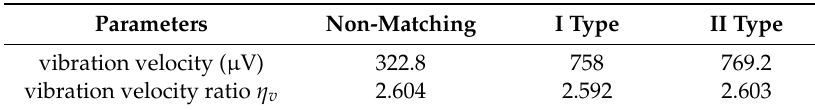
Figure 10. The vibration velocity of the single sandwiched piezoelectric ultrasonic transducer with EIM networks, ( a ) the vibration velocity of the front mass, ( b ) the vibration velocity of the back mass. Table 4. The vibration velocity of the front mass and vibration velocity ratio for single sandwiched piezoelectric ultrasonic transducer.